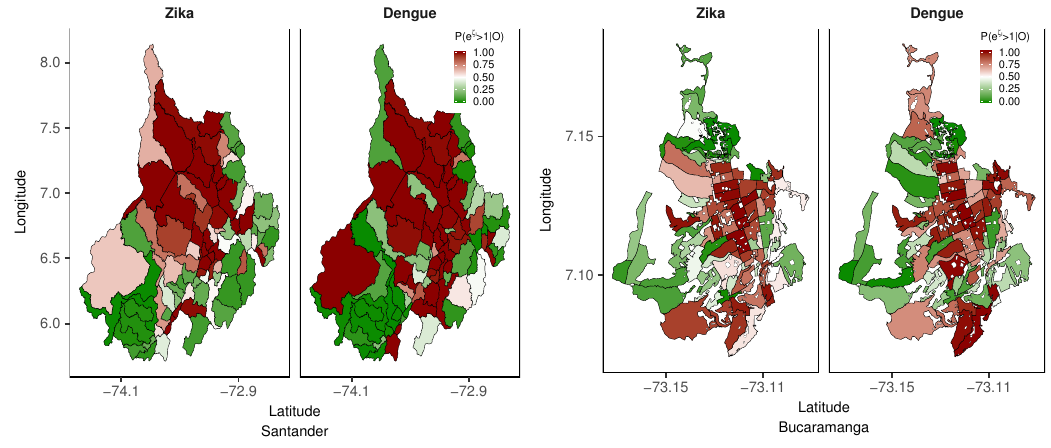
Figure 5. Probability of spatial structured effects greater than 1 ( P ( exp ( ζ i ) > 1 | O )) for department of Santander and city of Bucaramanga from October 2015 to December